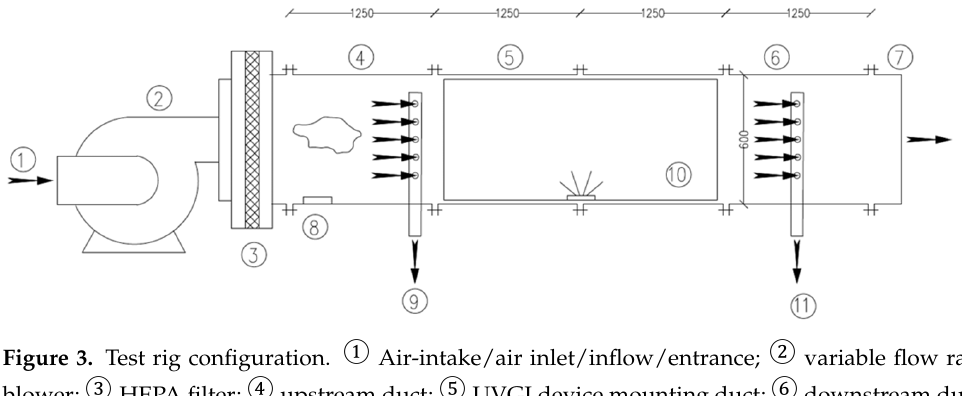
Figure 3. Test rig configuration. ① Air-intake/air inlet/inflow/entrance; ② variable flow rate blower; ③ HEPA filter; ④ upstream duct; ⑤ UVGI device mounting duct; ⑥ downstream duct; ⑦ off-gas pipe; ⑧ nebulizer; ⑨ upstream microorganism sampling port; ⑩ CSA system; ⑪ downstream microorganism sampling port.